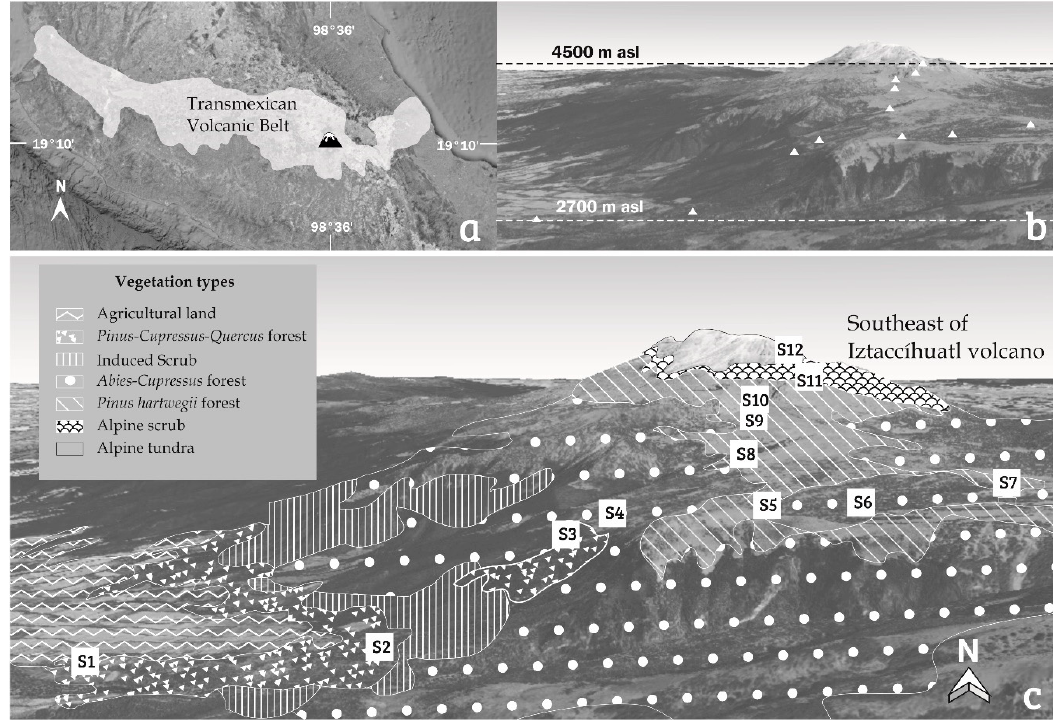
Figure 1. Map of the study area. ( a ) Trans Mexican Volcanic Belt (TMVB), Mexico; ( b ) altitudinal gradient sampled (2700–4500 m asl); and ( c ) geographical stations (S1–S12) with vegetation types. Table 1. Station, sample number, geographic coordinates, vegetation, and substrate type, of the mosses sampled in the southwestern slope of Iztaccíhuatl volcano.